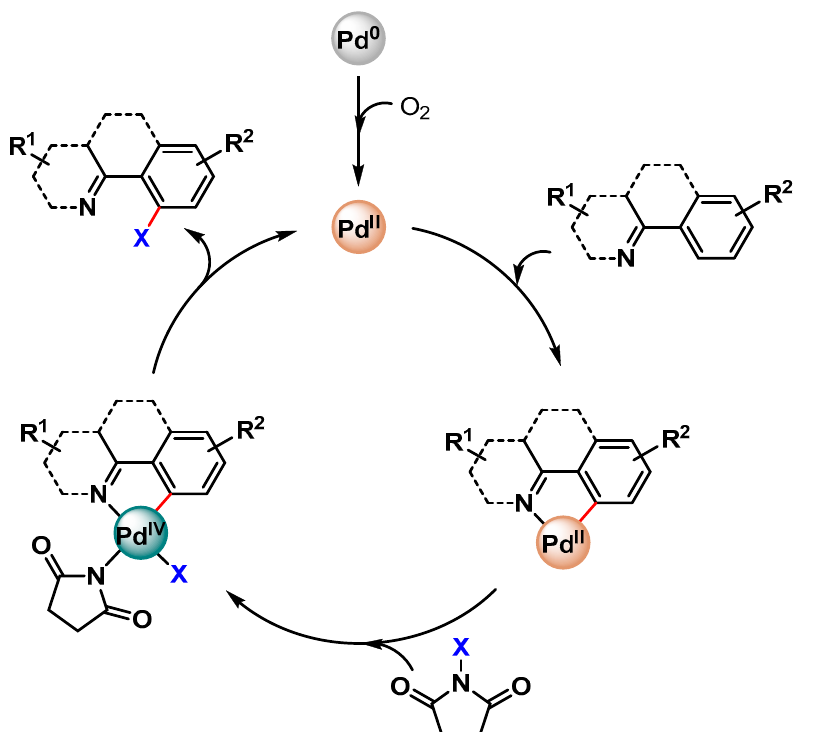
Scheme 24. Possible reaction mechanisms for Pd-catalyzed C–H